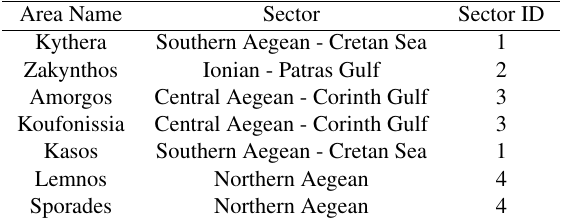
Table 1: Study areas and respective general sectors